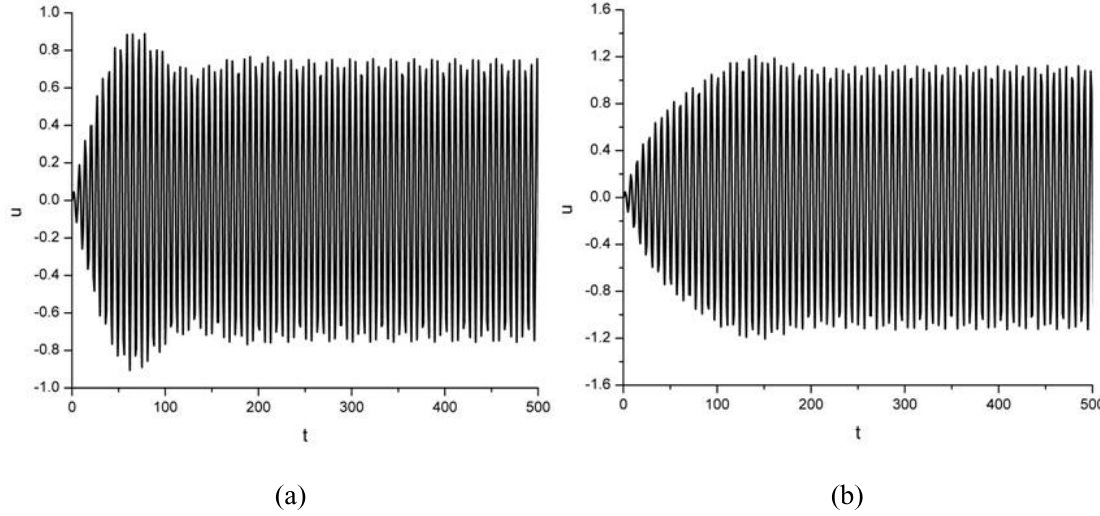
Fig. 15. Numerical simulation of the time responses of the plant for the open-loop case when (a) Ω = 1 . 0 and (b) Ω = 0 . 95 . ¨ v + 2 ζ ˙ v + ω 2 = ω 2 2 v 2